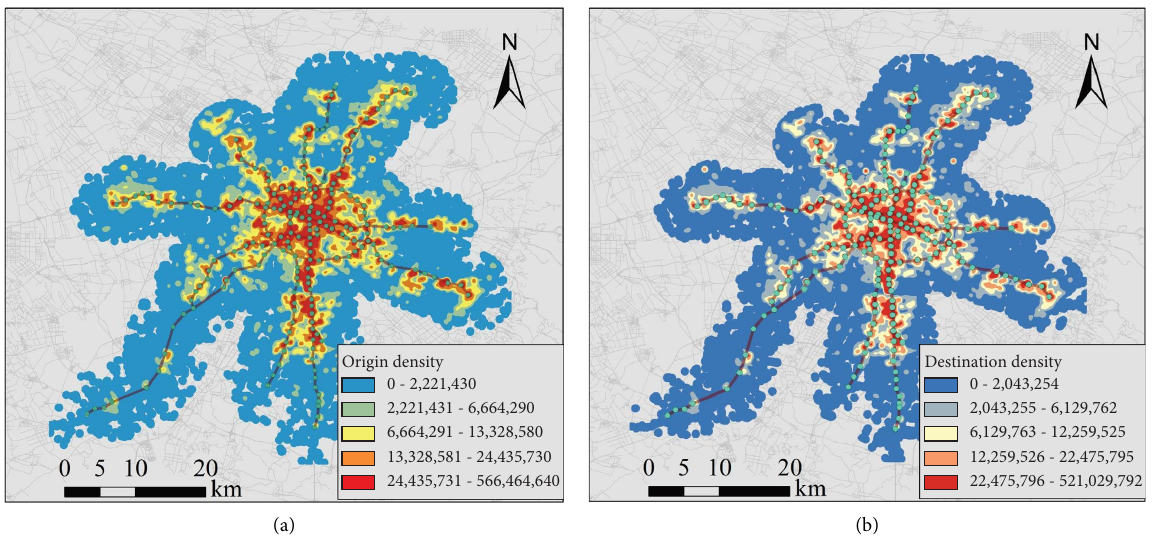
Figure 3: Spatial distribution of the origin and destination. (a) Kernal density of access trip and (b) kernal density of egress